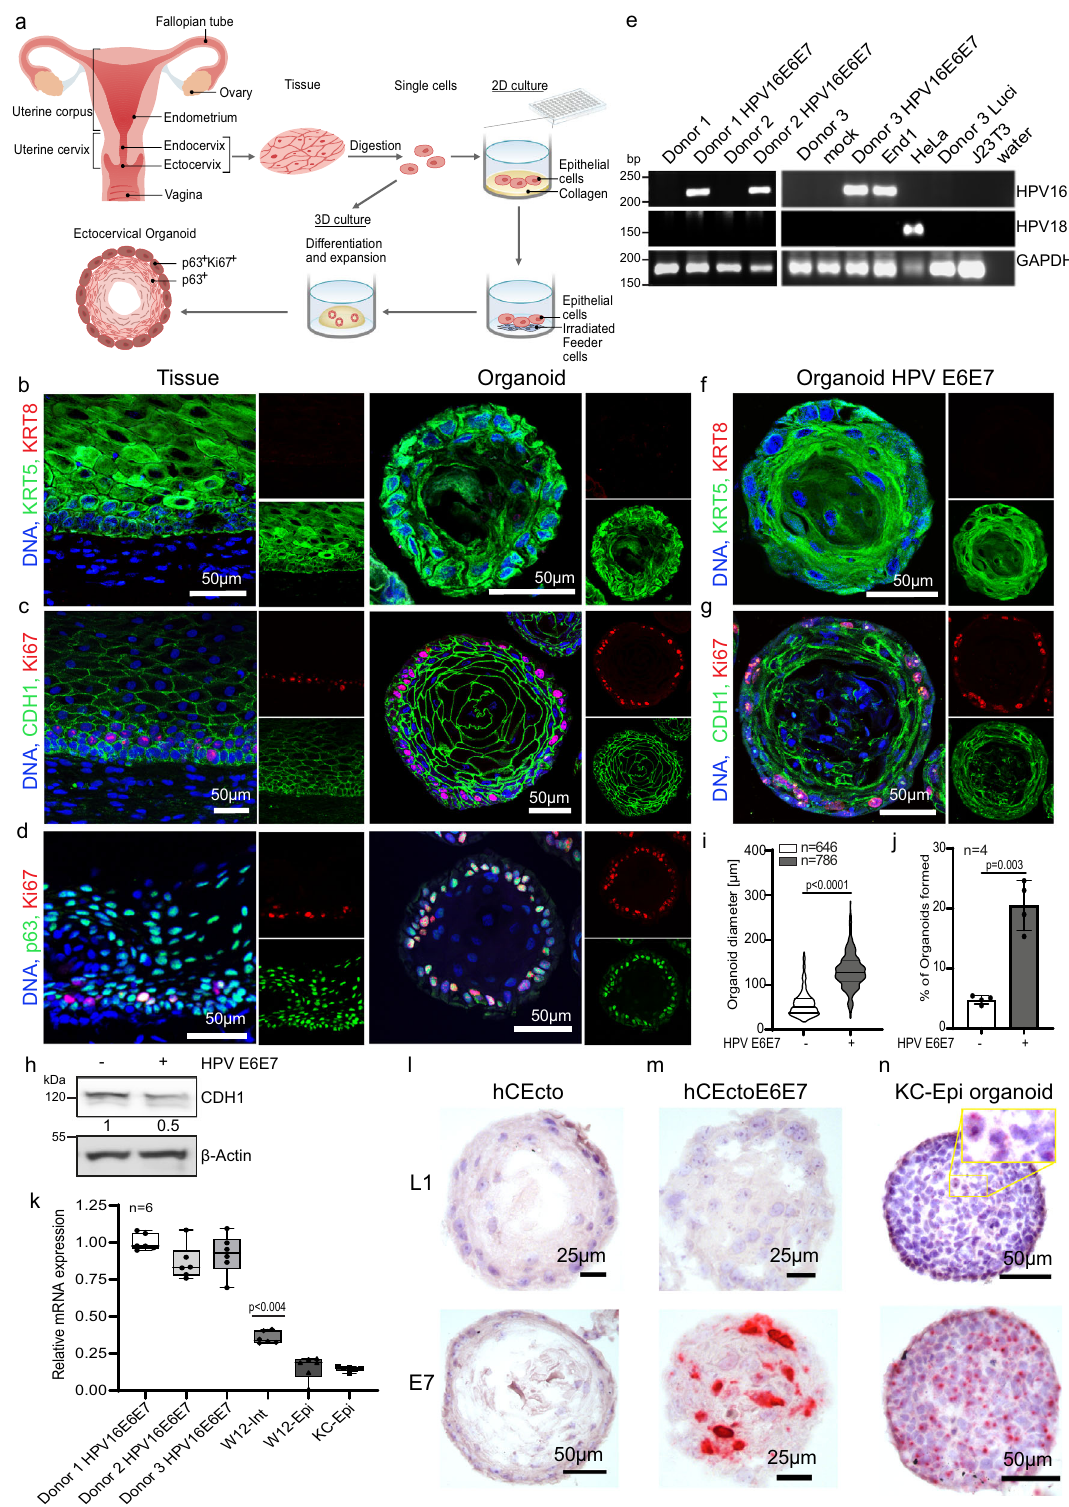
organoids. The two-week-old hCEcto E6E7 mature organoids consist of an outer layer of basal p63 + progenitors that are proliferative (Ki67 + ) and remain KRT5 + /KRT8 − (Fig. 1f, g, Supplementary Fig. 1c) similar to the normal ectocervical epithelium. However, a signi fi cant reduction and alteration in the distribution of adherens junction marker E-cadherin (CDH1), responsible for maintaining cell polarity and differentiation, was